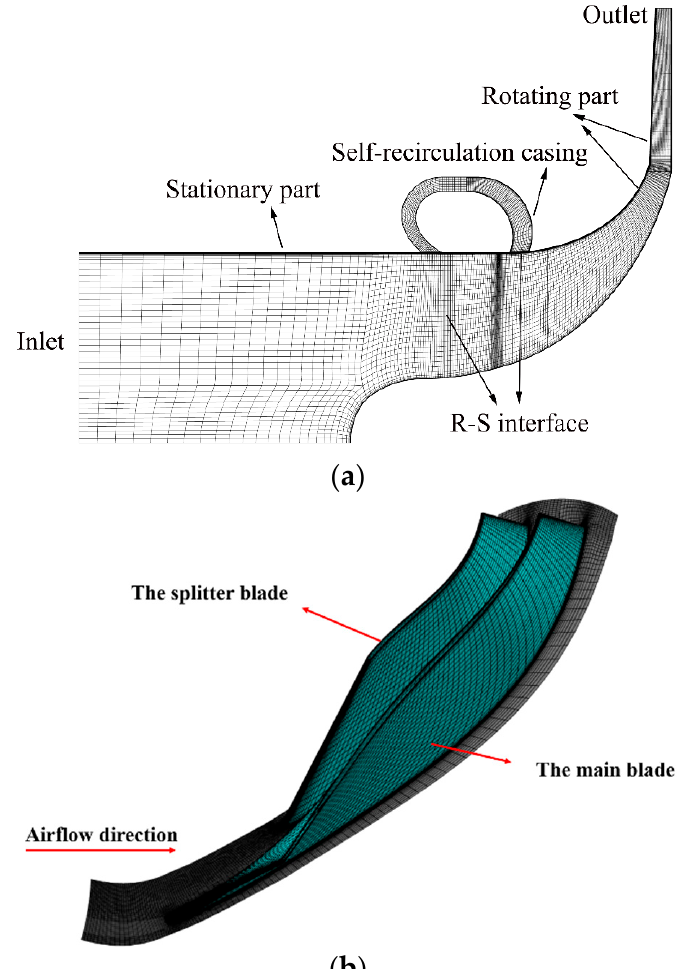
Figure 4. The diagram of computed domain grid. ( a ) A representation of the meridional plane of the computational grid. ( b ) Three-dimensional diagram of the blade grids.